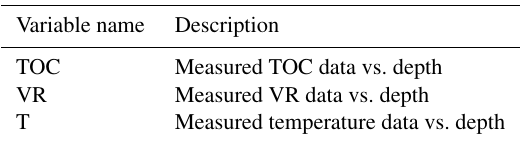
Table 4. List of variables in the “welldata” struct variable of the output